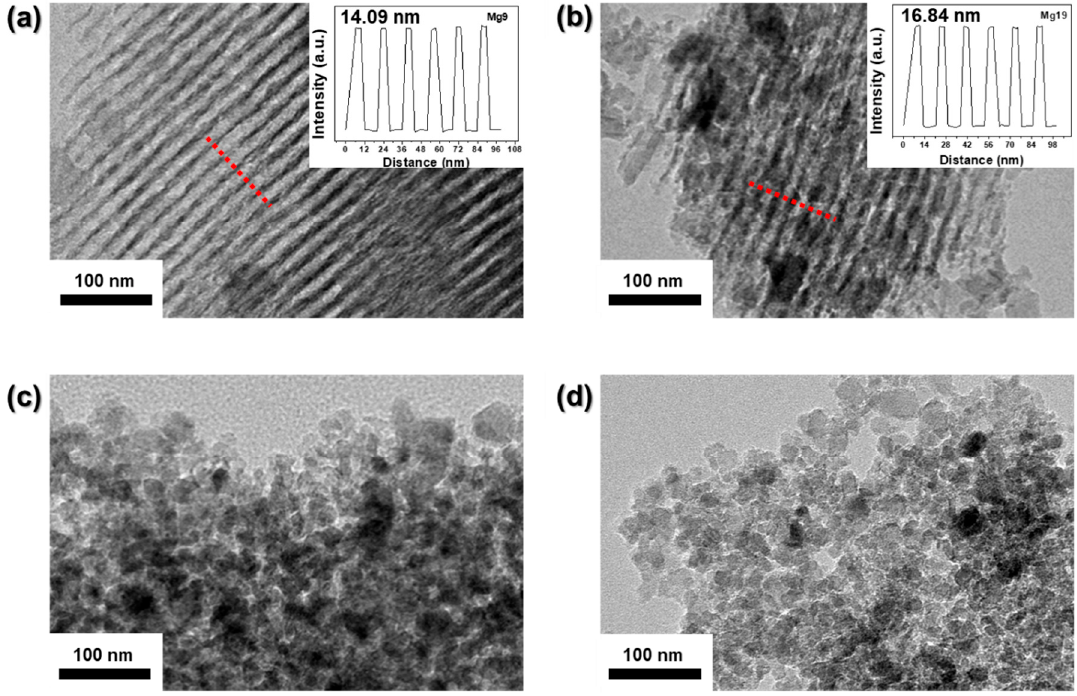
Figure 1. TEM images of mesoporous Mg-aluminate support calcined at 900 °C: ( a ) Mg9, ( b ) Mg19, ( c ) Mg25, ( d ) Mg30. ( c ) Mg25, ( d )